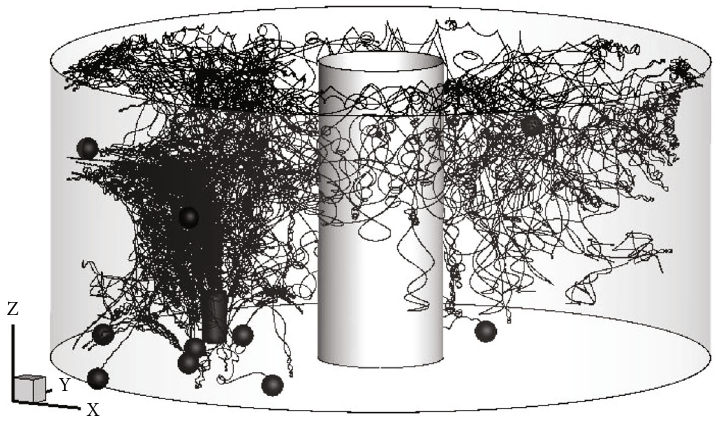
Figure 22: Primary electron trajectories under 6 times the initial magnetic fi eld strength.